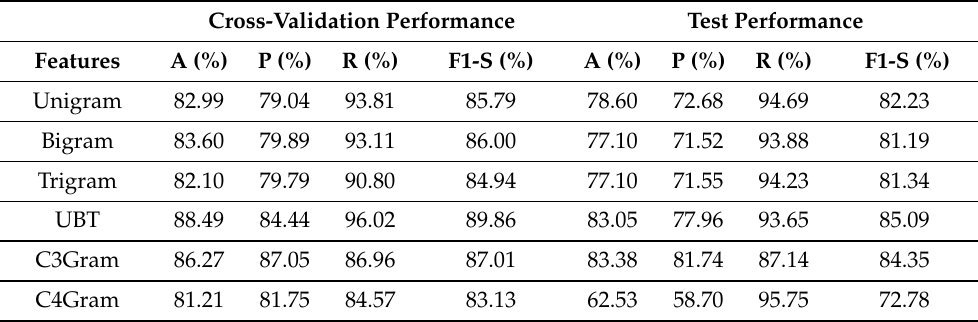
Table 8. Performance of Stochastic Gradient Descent (SGD) machine learning